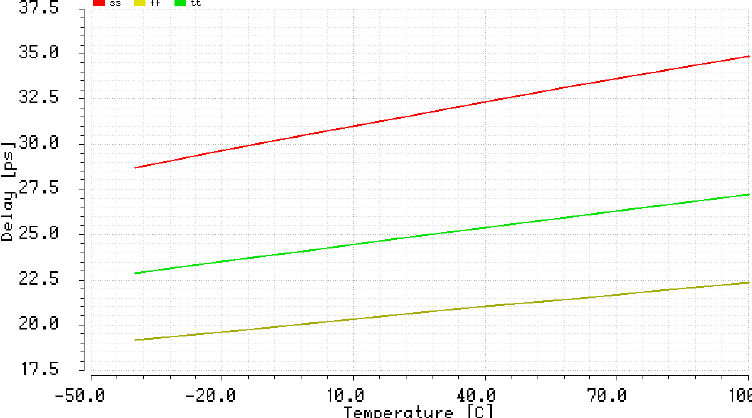
Figure 41. Unit delay vs. operating temperature for slow-slow (ss), typical-typical (tt) and fast-fast (ff) corners.